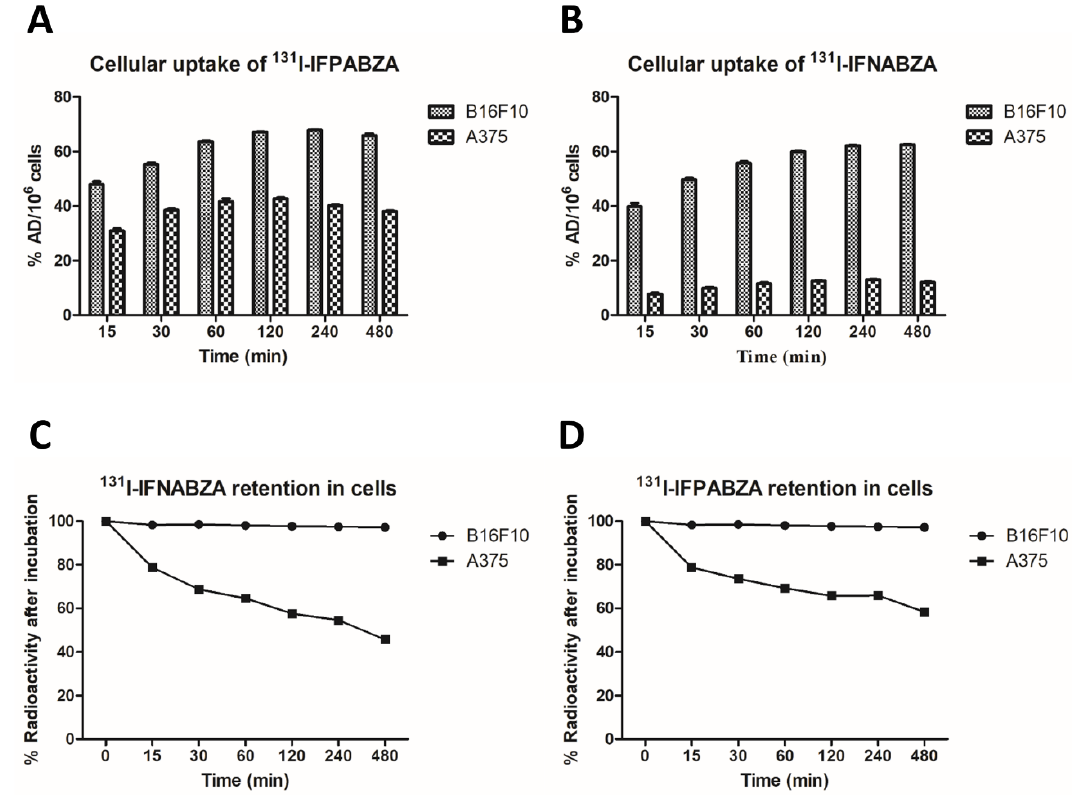
Figure 5. Cellular uptake of ( A ) 131 I-IFPABZA and ( B ) 131 I-IFNABZA in B16F10 murine melanoma and A375 human melanoma cells. Washout studies of ( C ) 131 I-IFPABZA and ( D ) 131 I-IFNABZA in B16F10 and A375 cells All treatments were repeated in six times (n = 6), and data were expressed as mean ± SD.